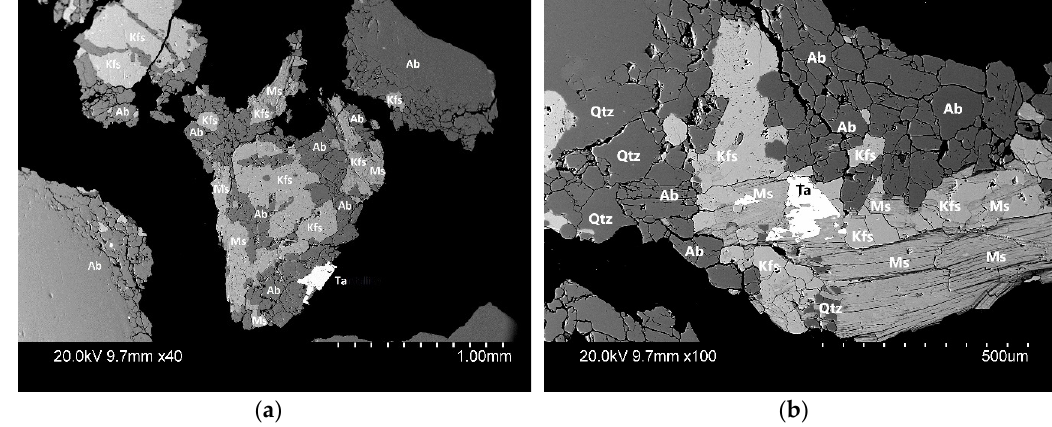
Figure 10. Backscattered electron image of composite particles after IPB considering 10% compression ratio. A composite particle of a tantalite (Ta) grain embedded in ( a ) albite (Ab) and ( b ) muscovite (Ms), albite (Ab), quartz (Qtz) and K-felspar (Kfs).